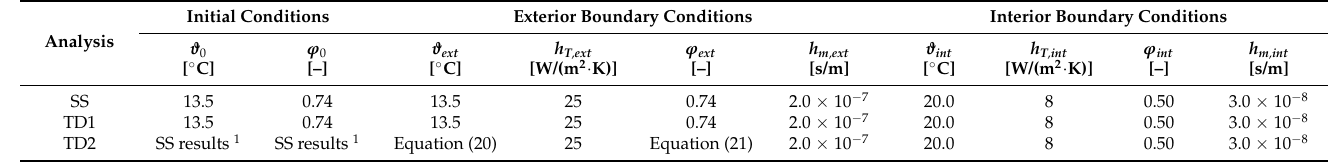
Table 2. Summary of the initial and boundary conditions used for the hygro-thermal